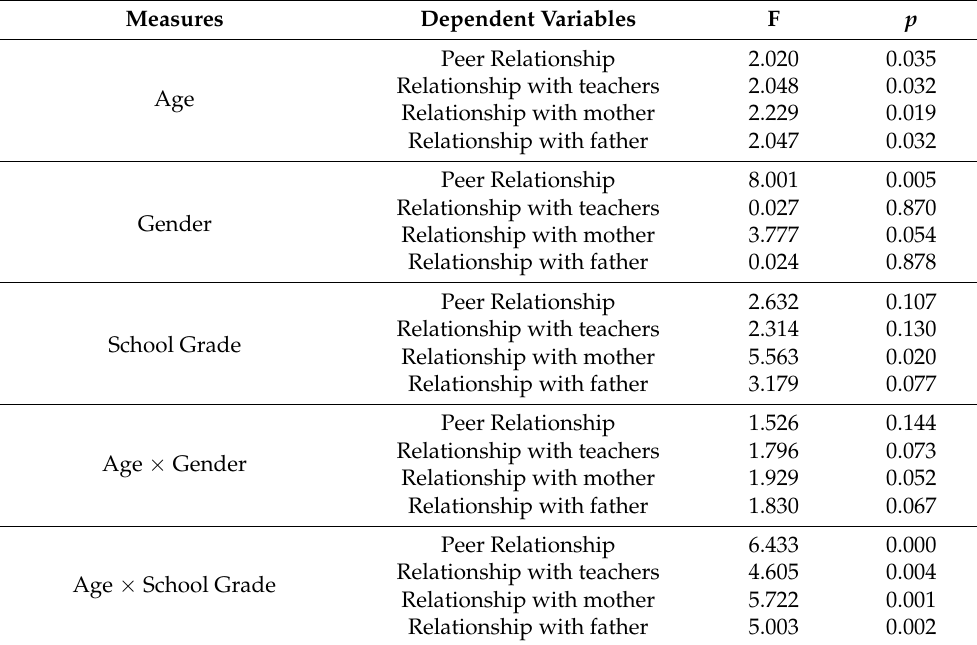
Table 9. MANOVA: influence of independent variables on relational